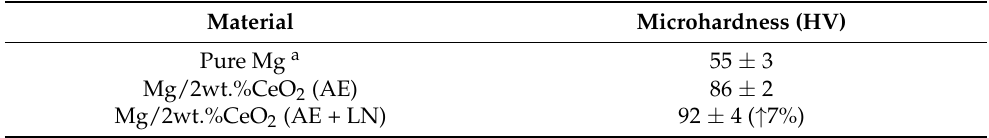
Table 4. Results of microhardness